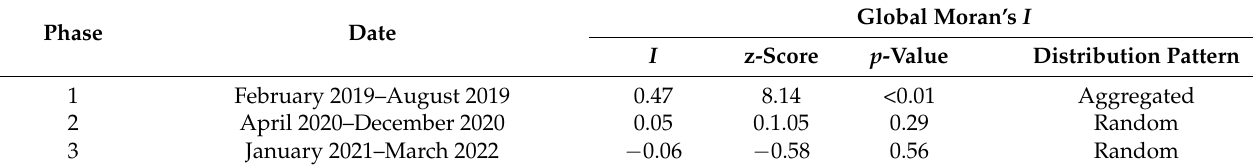
Figure 3. The monthly outbreak centers and average spread direction of the ASF (February 2019– March 2022). Table 2. The directional test result of the ASF (February 2019–March 2022). Table 3. Global Moran’s I of the ASF occurrence rate in Vietnam (February 2019–March 2022).